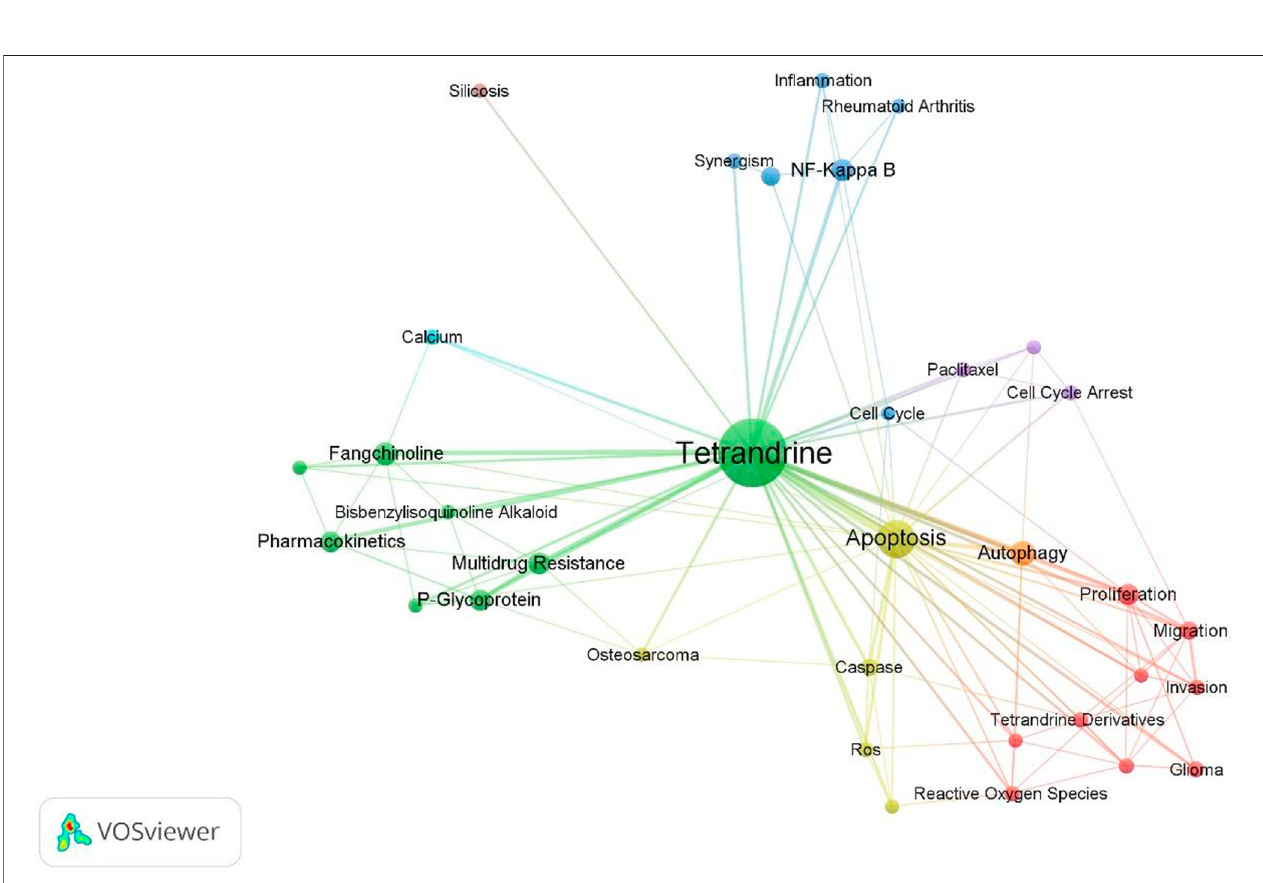
FIGURE 6 | Network visualization map of the author keywords. keywords with similar colors form one cluster.